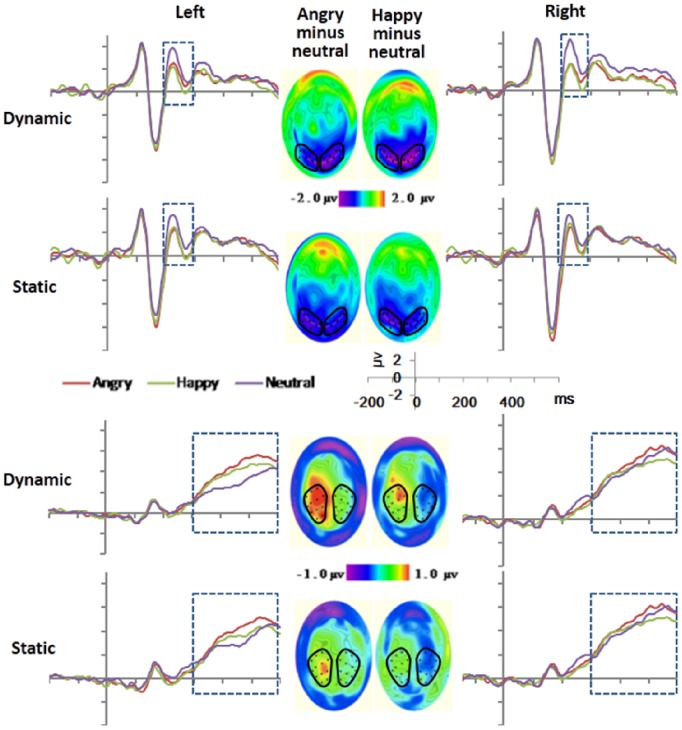
Waveforms and topographic maps (with nose up) for the EPN (top), and the LPC (bottom), showing grand averaged amplitude at the selected sensors clusters.The topographic maps of the EPN and LPC show subtractive waves of emotional (angry, happy) minus neutral.